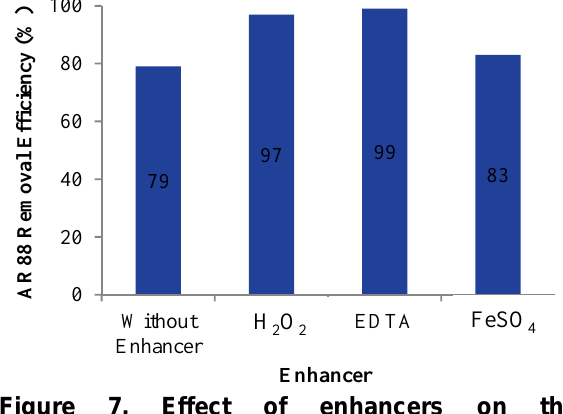
Figure 7. Effect of enhancers on the photocatalytic removal of Acid Red 88 (AR88) from aqueous solutions (initial dye concentration: 50 mg/l, pH: 7, time: 120